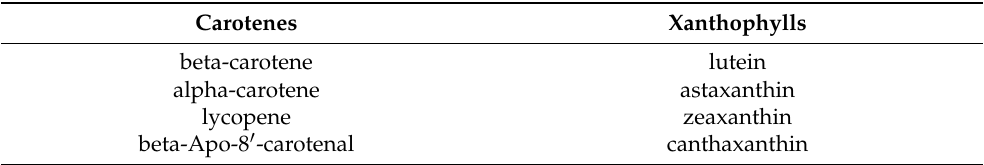
Table 1. Examples of carotenes and xanthophylls.